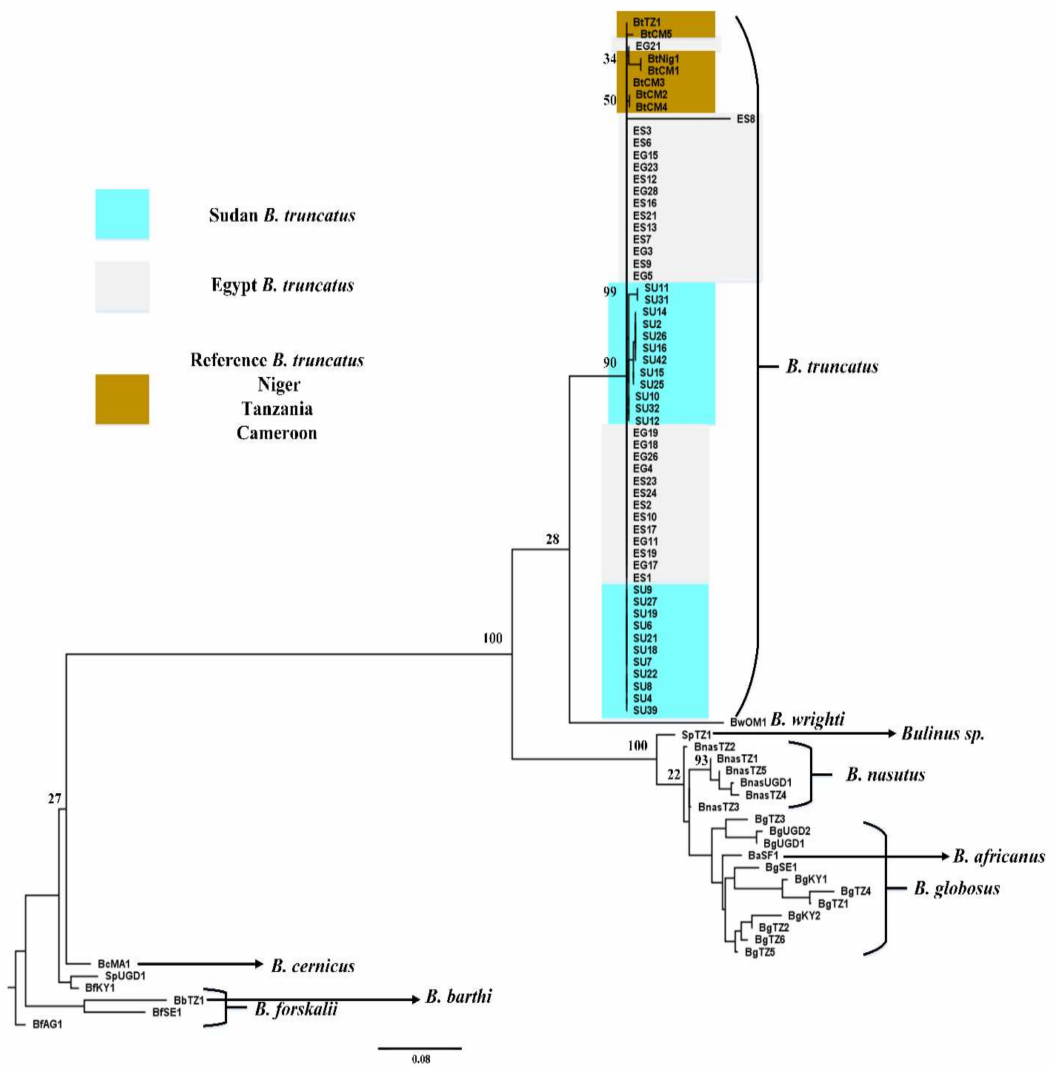
Figure 3. A rooted maximum likelihood tree of Bulinus truncatus for ITS 1 sequences. Maximum likelihood tree of a 580 bp fragment of the internal transcribed spacer 1 (ITS 1) for B. truncatus in this study with an additional 33 published Genbank sequences including B. truncatus reference